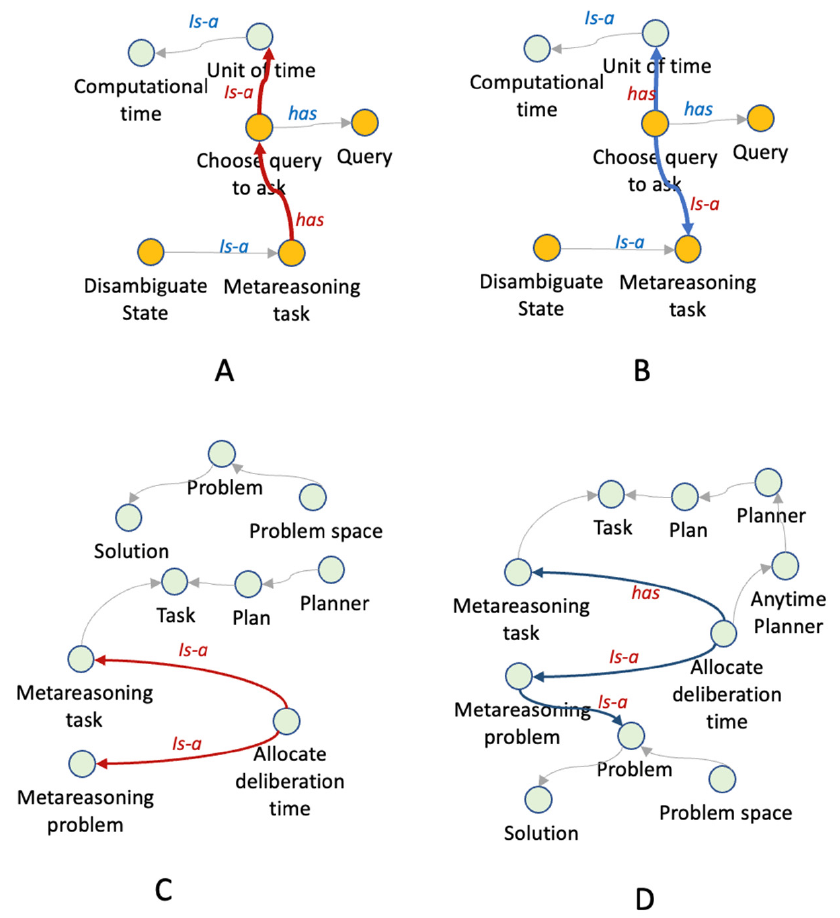
Figure 19. Examples of errors detected in expert validation. Section ( A ) shows two semantic errors in the relations colored in red, and section ( B ) shows the adjustments suggested by the experts. Section ( C ) shows an “incompleteness” error, where the experts commented that class ALLOCATE_ DELIBERATION_TIME was inherited from two different classes, which was confusing. Section ( D ) presents the suggestion given by the